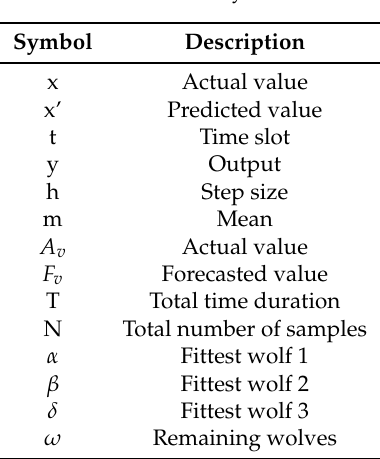
Table 3. List of